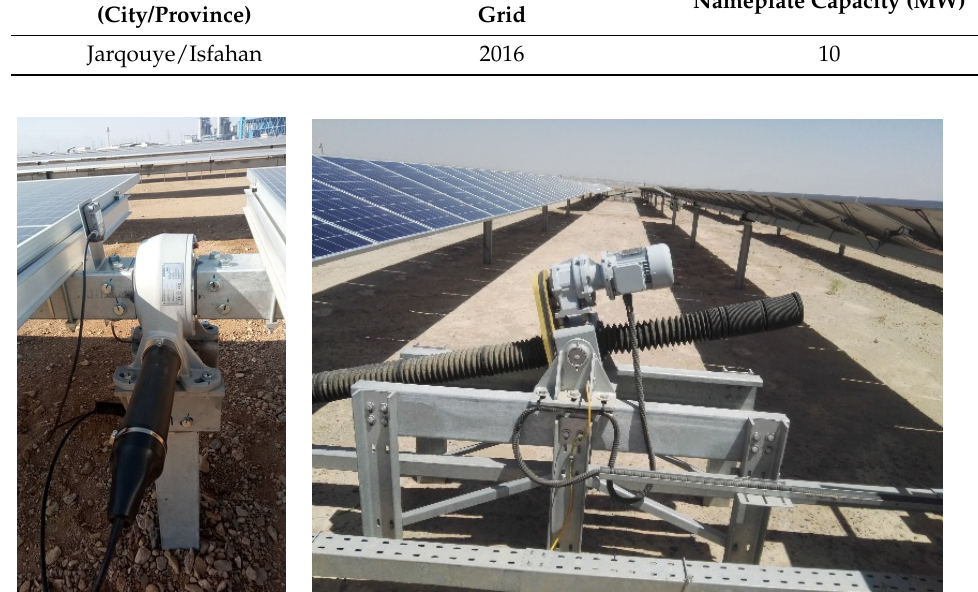
Figure 12. Two types of solar trackers installed in the Iranian power plants.